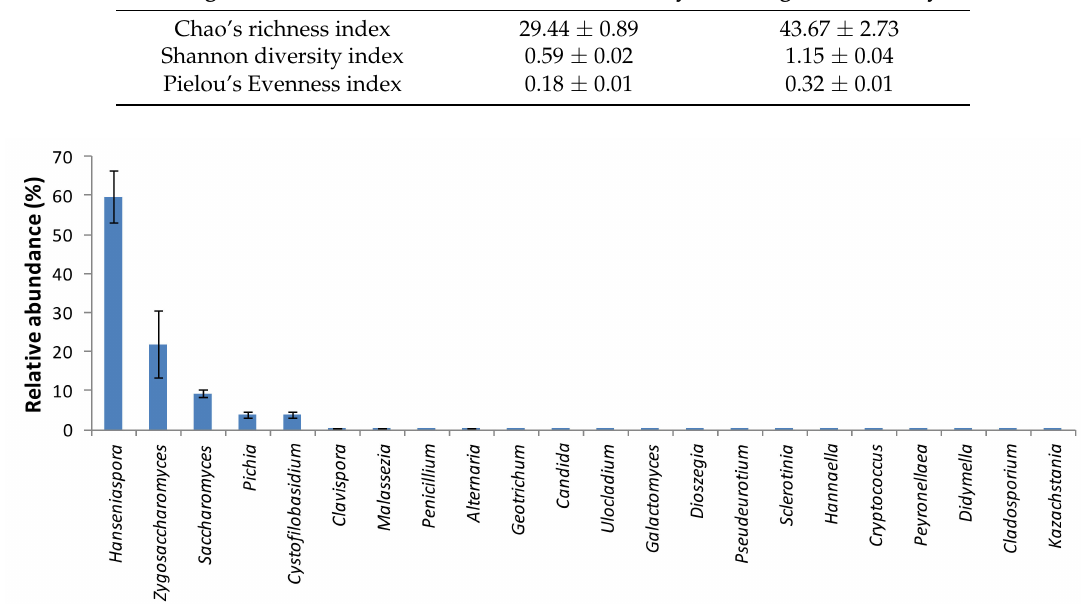
Figure 7. Fungal diversity in the orange juice processing waste examined by Illumina assay technology. Only fungal taxa with relative abundance above 0.01% are shown in the bar